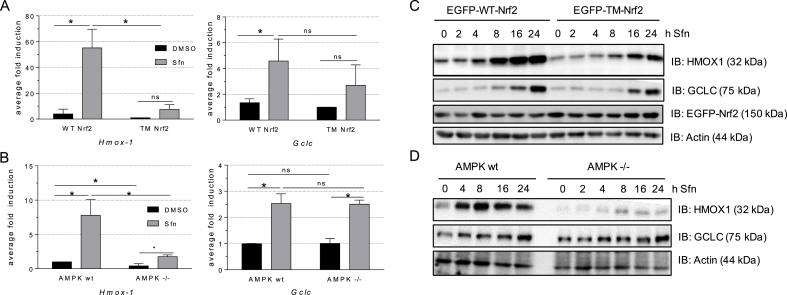
AMPK-dependent phosphosites in Nrf2 enhance expression of selected endogenous Nrf2 target genes. (A) MEF Nrf2 −/− cells transfected with EGFP-WT- or EGFP-TM-Nrf2 and (B) wt or AMPKα1 −/− MEF were treated with DMSO as vehicle control or sulforaphane (Sfn, 5 μM) for 4 h. RNA was extracted and analyzed for abundance of Hmox1 and Gclc mRNA by qPCR (Hprt as reference gene). Bars depict compiled relative expression levels. (n = 3; mean +SD, unpaired Student's or Welch's t-test, α = 0.05, *P ≤ 0.05, ns: not significant. (C) MEF Nrf2 −/− cells transfected with EGFP-WT- or EGFP-TM-Nrf2 and (D) wt or AMPKα1 −/− MEF were treated with Sfn (5 μM) for the indicated periods of time. Proteins were extracted and subjected to immunoblot analysis for HMOX1, GCLC, GFP (=EGFP-WT- or EGFP-TM-Nrf2) and actin as loading control. The depicted blots are representative for three independent biological replicates with consistent results.